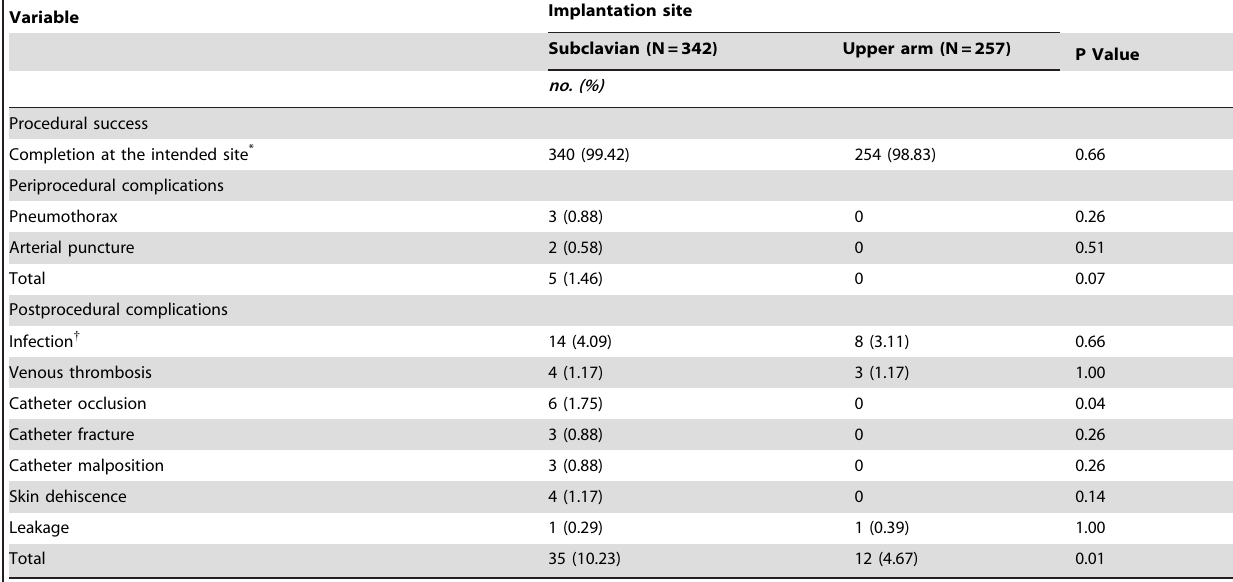
Table 2. Proportion of Success and Complications.